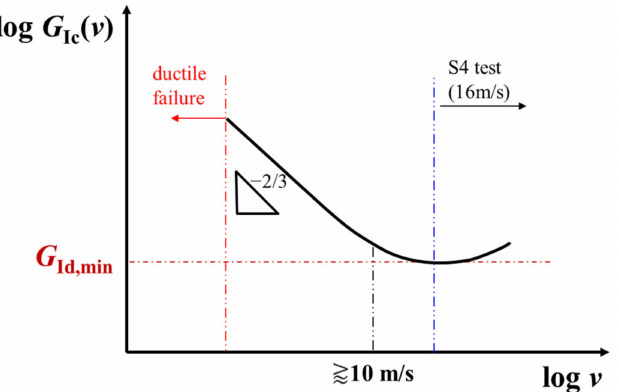
Figure 7. Schematic illustration of a time-dependent initiation energy release rate G Ic ( v ) as a function of the load rate v for rate-sensitive materials with dominating embrittlement (in accordance to [13]). Subsequently, the soft rubber parts of the microstructure at the vicinity of the fast- running crack tip have no time to follow the governing local crack opening